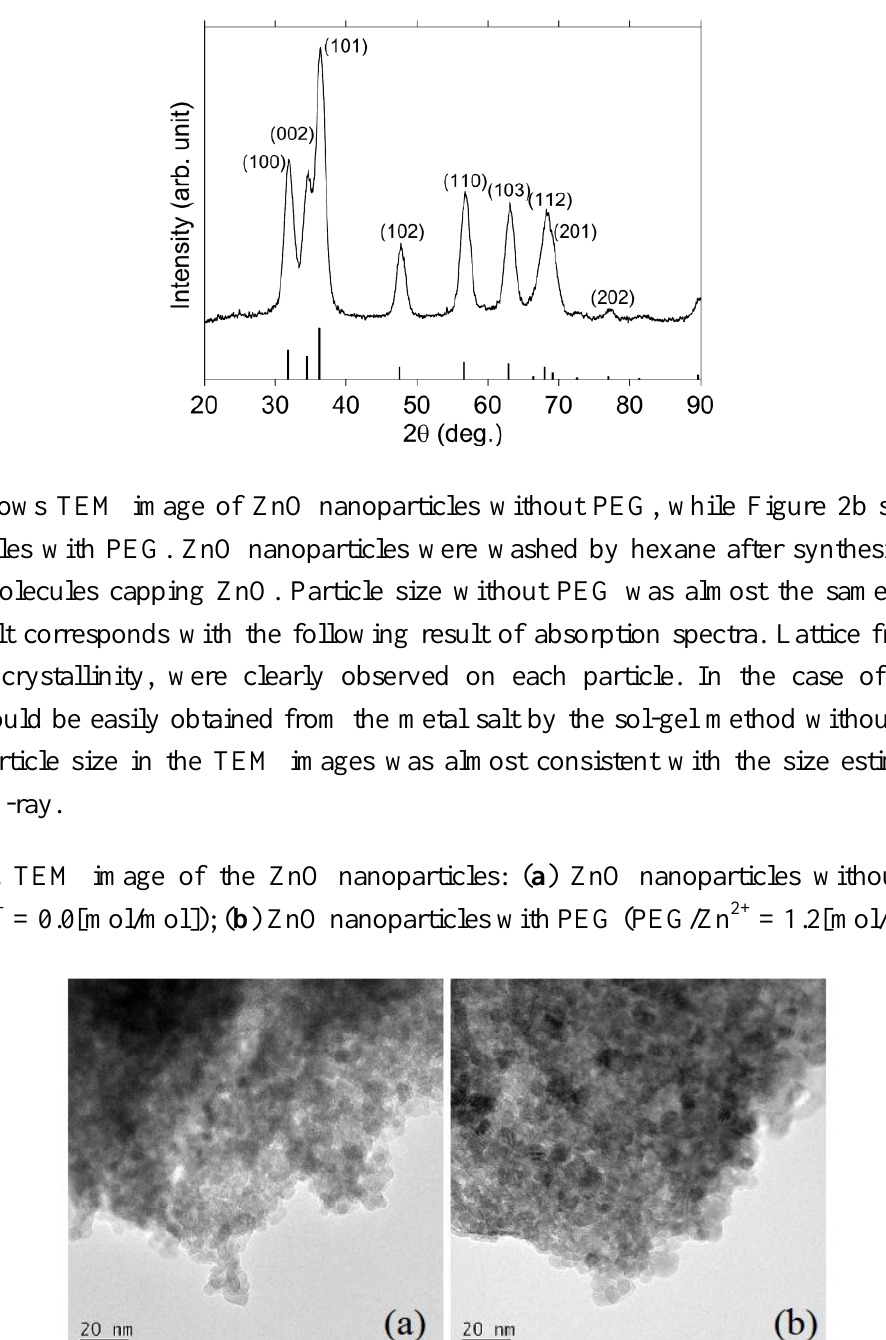
Figure 1. XRD pattern of the synthesized nanoparticles.